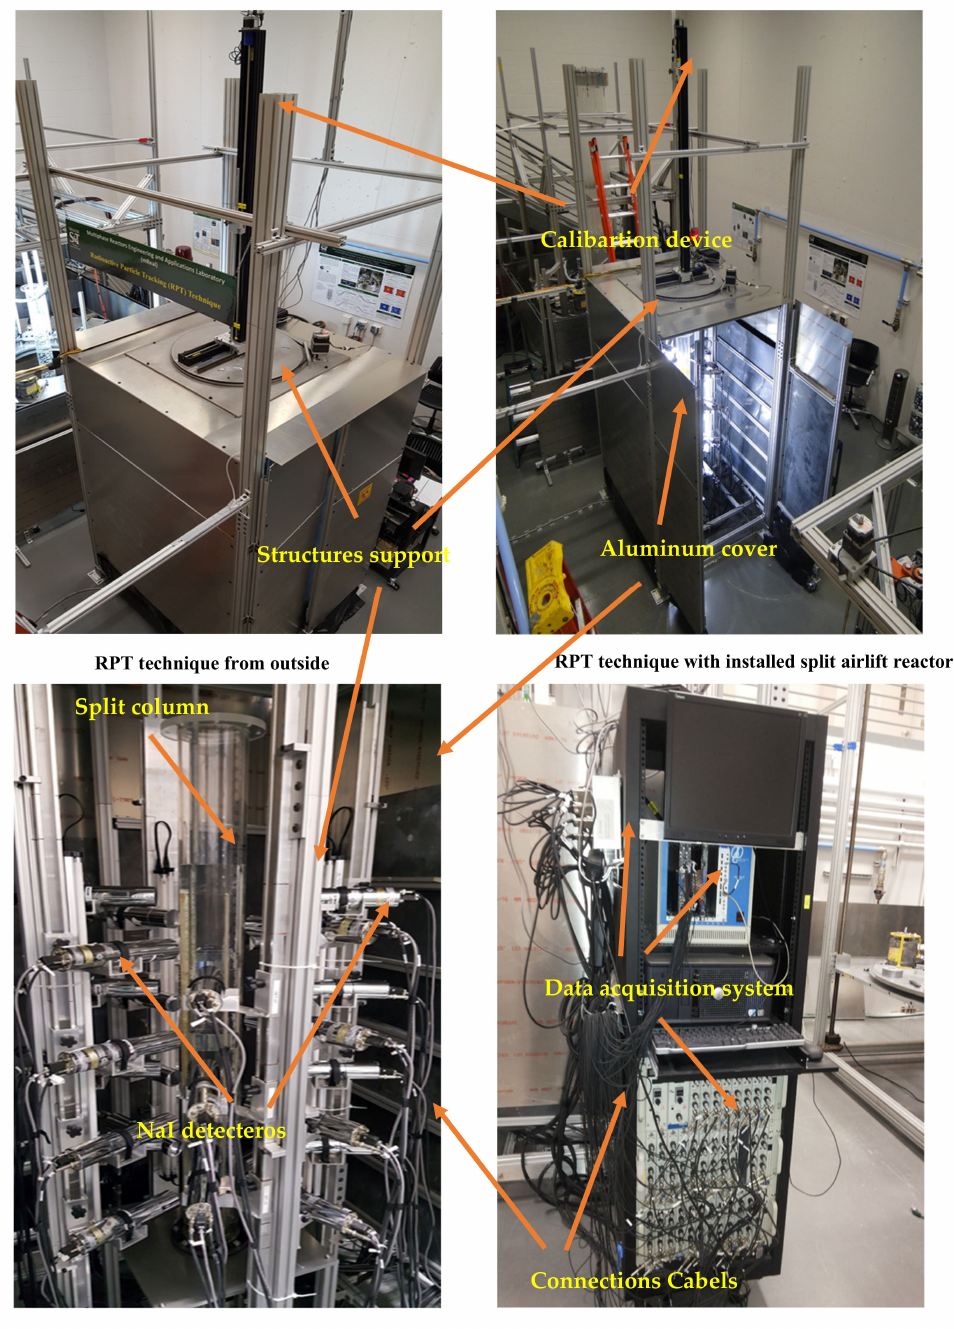
Figure 4. Photos of RPT technique with split plate airlift